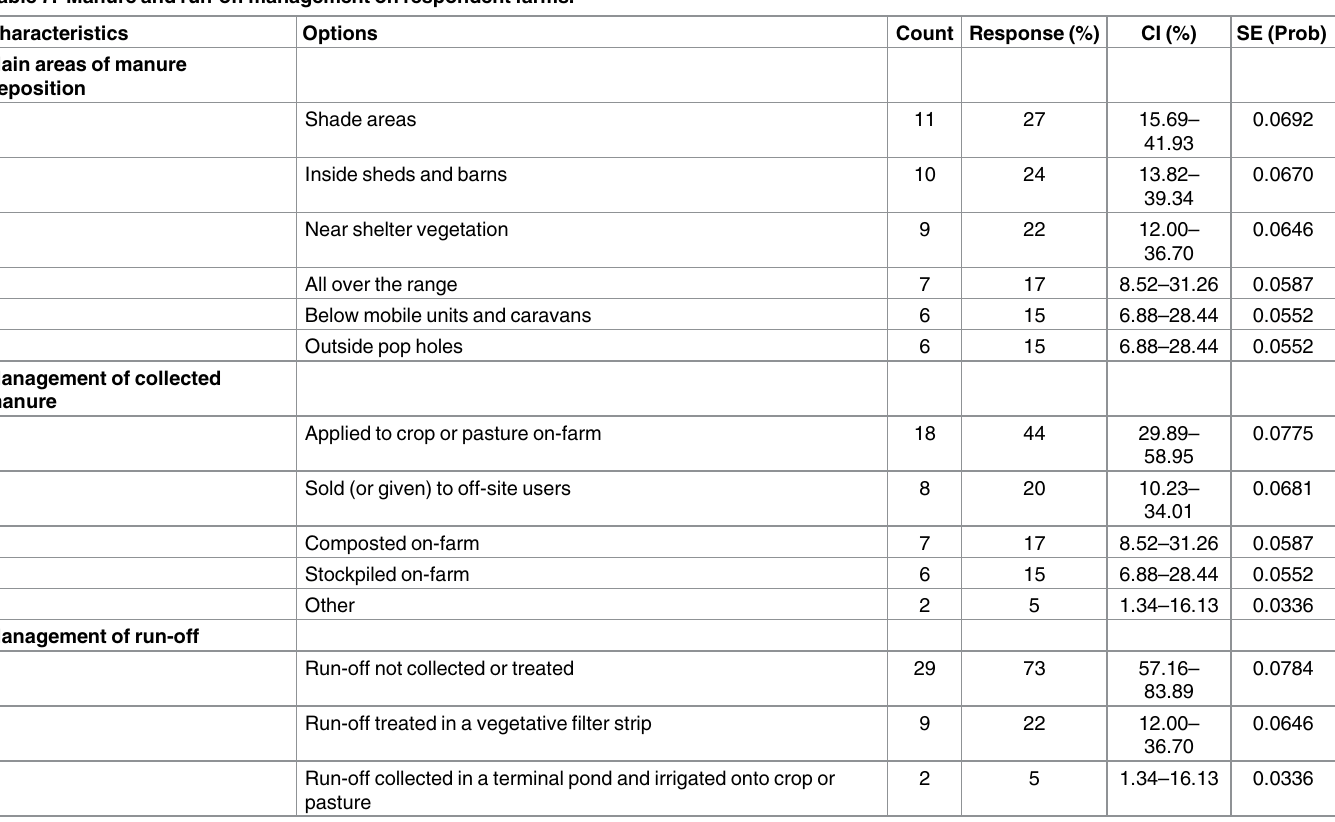
Table 7. Manure and run-off management on respondent